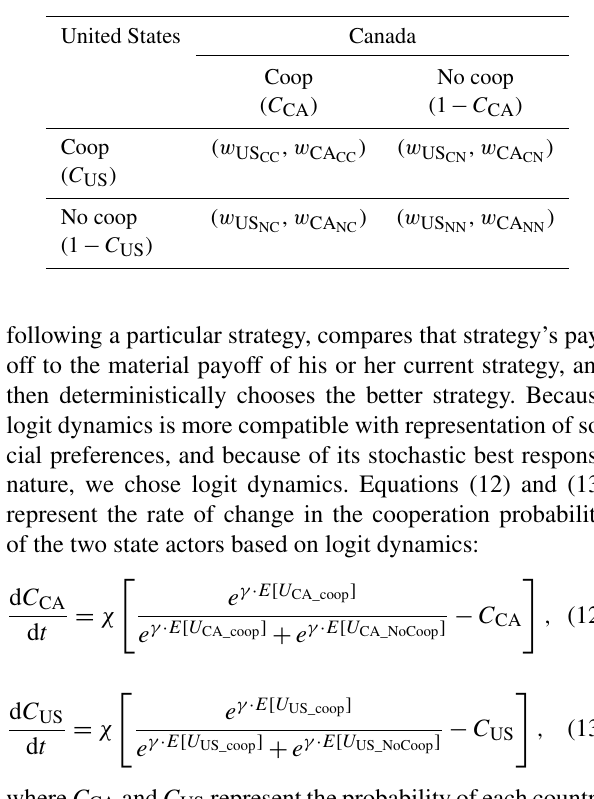
Table 2. The payoff matrix of the mixed-strategy prisoner’s dilemma between Canada and United States showing monetary ben- efit for Canada ( w CA_ ) and the United States ( w US_ ) in four con- ditions: CC – the US and Canada both cooperate, CN – the United States cooperates and Canada does not, NC – the United States does not cooperate and Canada does, and NN – the United States and Canada both do not